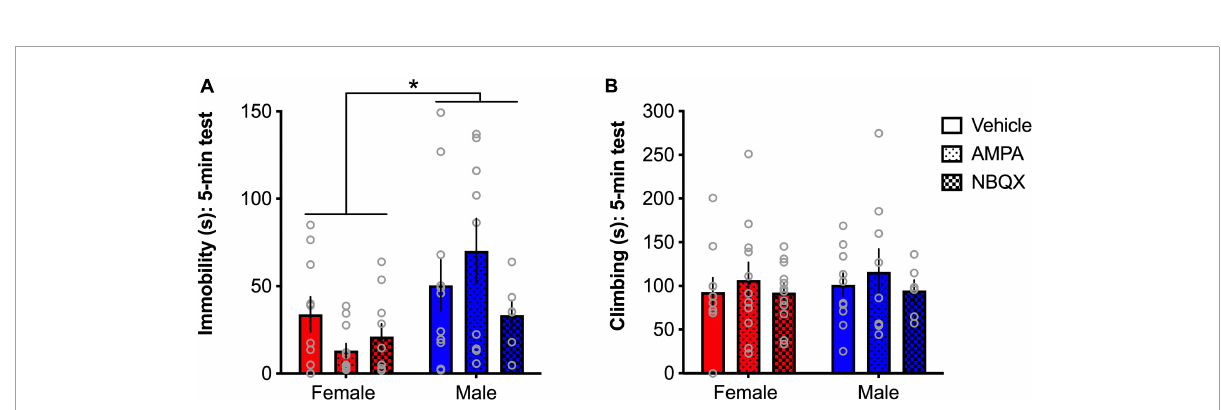
FIGURE8 AMPA receptors differentially regulate depressive-like behavior in male and female rats. Females spend significantly less time immobile than males (A) , but no differences were found for climbing (B) . A trend for a sex × treatment interaction and visual examination of the patterns of effects show that AMPA decreased immobility in females and increased immobility in males. * p < 0.05 (male vs.